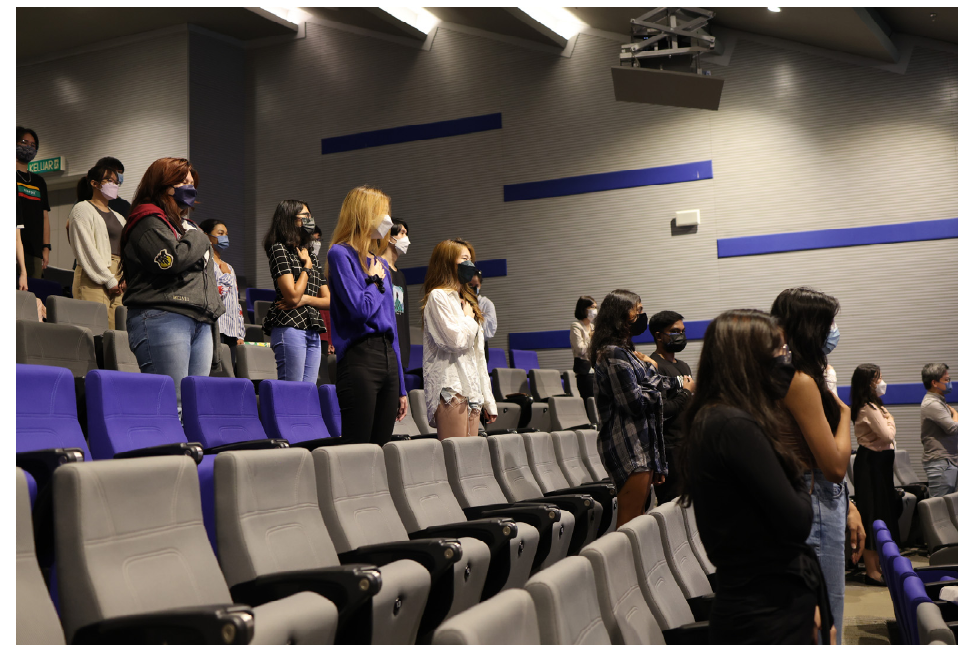
Figure 2. Students reciting the Planetary Health Pledge as part of the undergraduate course on “Community Service for Planetary Health”. “Community Service for Planetary